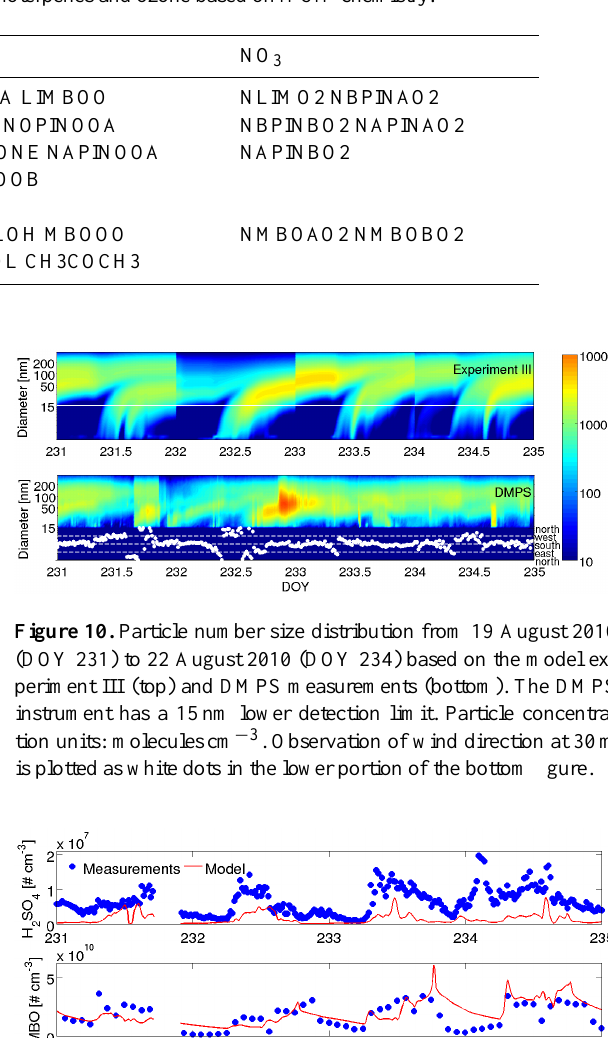
Table 2. Stable reaction products of OH, O 3 and NO 3 oxidation of monoterpenes and ozone based on MCM chemistry.